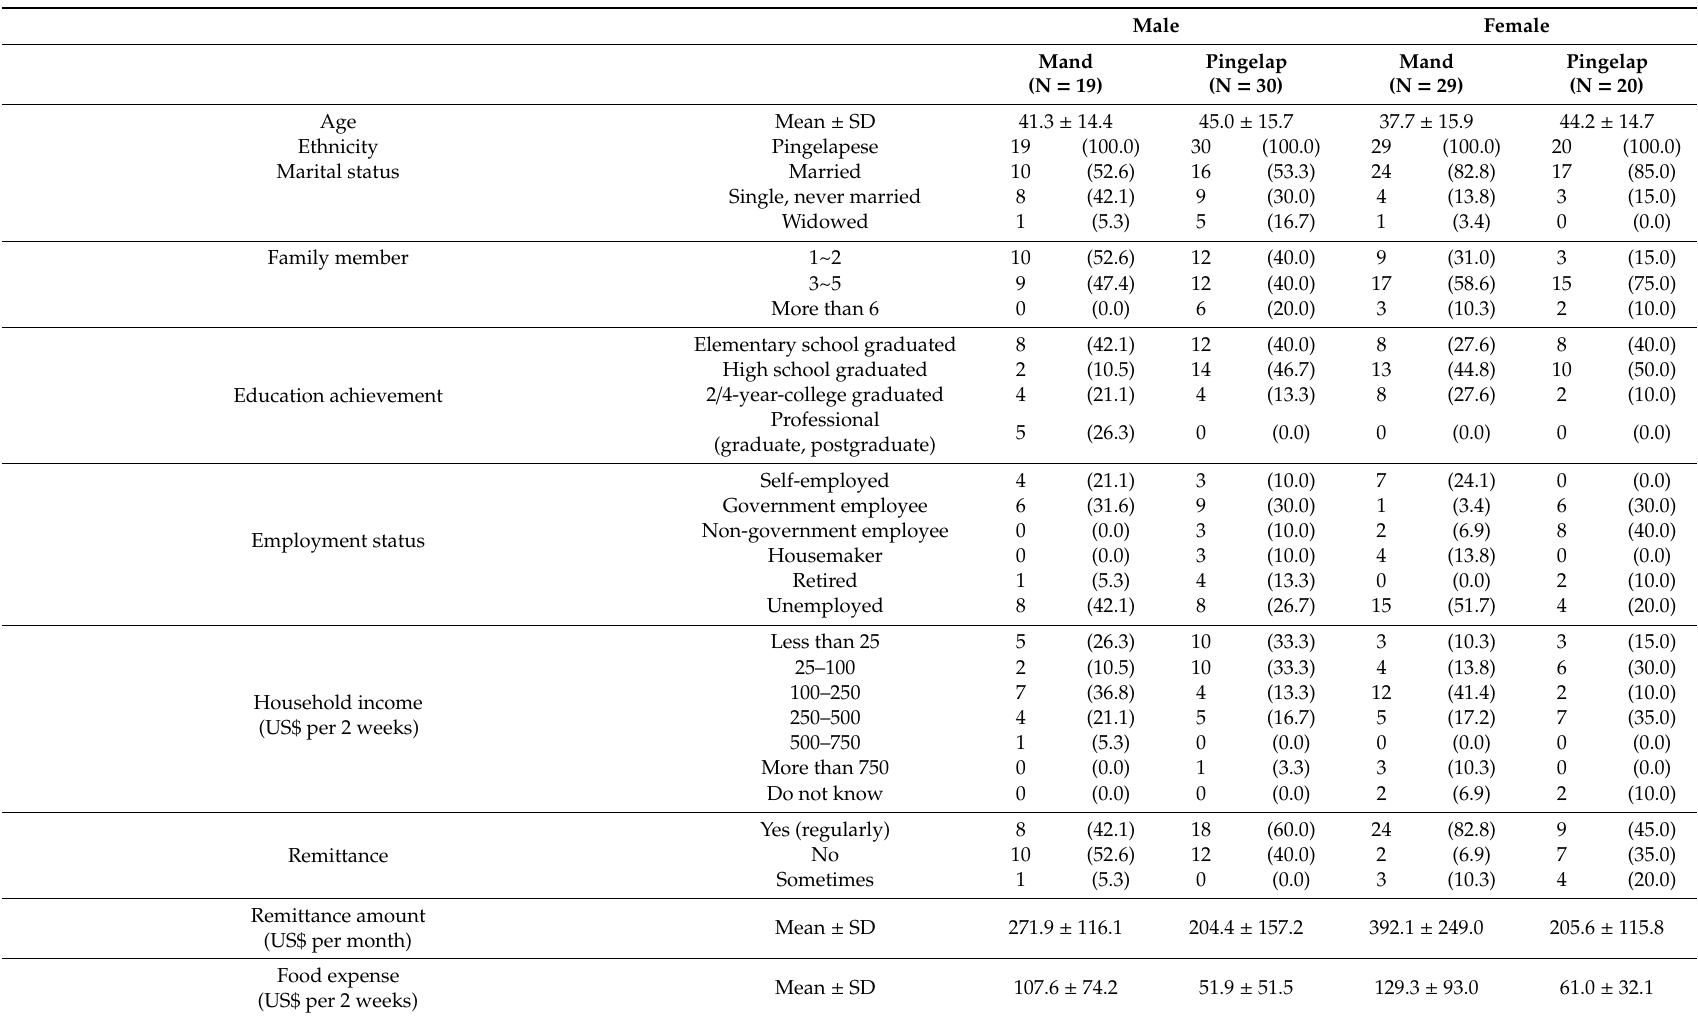
Table 2. Data on demographic information and behavior of the participants from the two communities according to